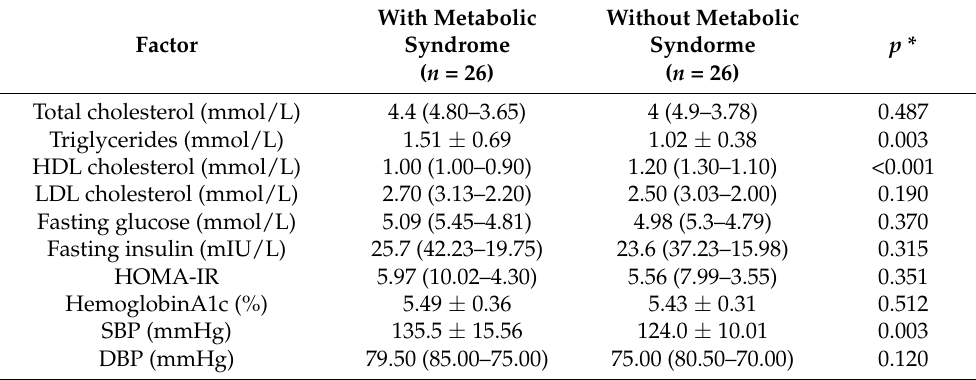
Table 2. Biochemical characteristics of the research subjects.